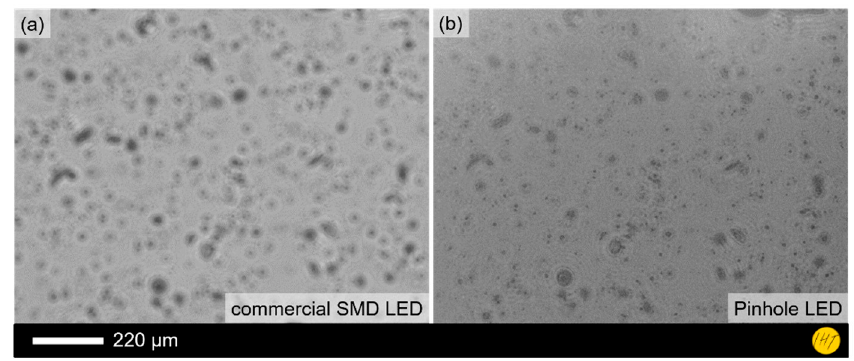
Figure 3. Side ‐ by ‐ side comparison of reconstructed inline ‐ holographic images of 5 μ m polystyrene microbeads embedded in transparent polydimethylsiloxane (PDMS) mold using illuminations of ( a ) a commercial blue SMD LED with a size of 230 × 230 μ m 2 and ( b ) a single pinhole LED with diameter of 90 μ m, both at a wavelength of 465 nm. In contrast to ( a ), clear diffraction patterns can be seen in ( b ) due to the larger spatial coherence length of the